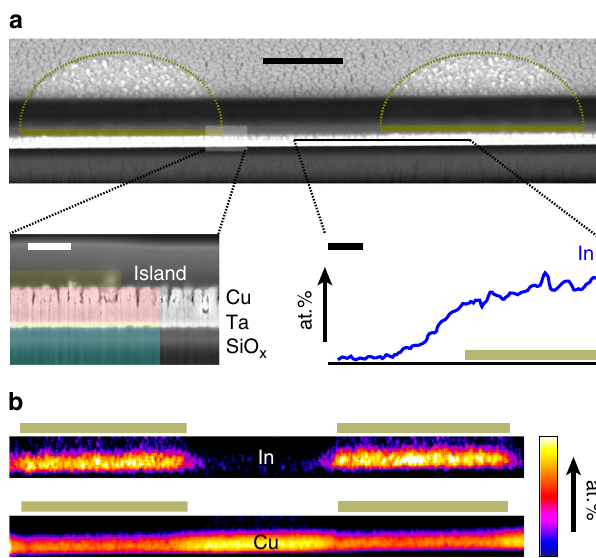
Fig. 6 Cross-section analysis after the catalytic testing. a Cross-section of a representative In 2 O 3 /Cu 2 O ( d = 5 μ m) electrode comprising two adjacent islands after the CO 2 reduction reaction obtained by FIB-SEM. Insets: multilayer structure (left) and variation of the concentration of indium along the indicated line obtained by EDX (right). Scale bars: 2 μ m (main image), 400 nm (insets). b In and Cu elemental maps spanning the substrate and islands as shown in a . The borders of the islands and their corresponding position in the cross-sections are indicated in